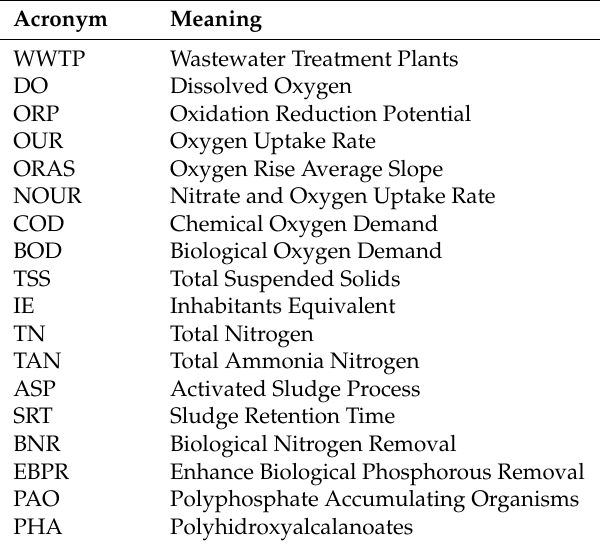
Table A1. Meaning of the acronyms used in the